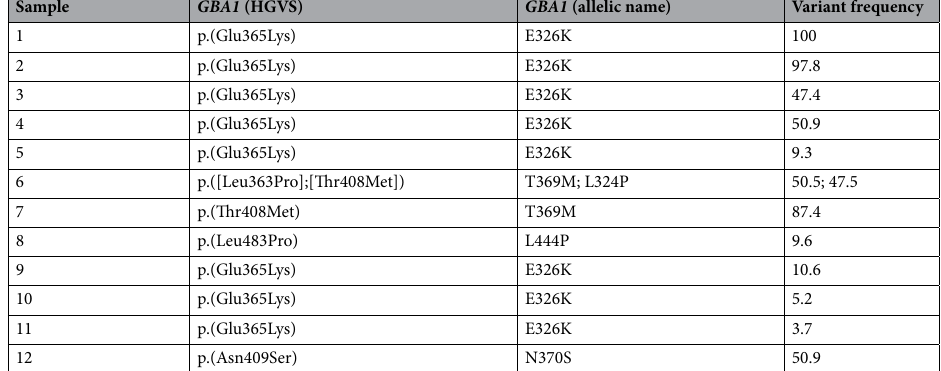
Table 3. Selection of twelve PD samples with varying GBA1 variant frequencies. Samples 5, 8, 9, 10 and 11 have an abnormally low variant frequency and sample 7 has a frequency too high for a normal heterozygous and too low for a normal homozygous variant. Sample 6 is compound heterozygous (T369M on one allele and L324P on the other allele). Both the HGVS nomenclature is given and the GBA1 allelic name, which excludes the 39-amino acid signaling peptide, both using accession